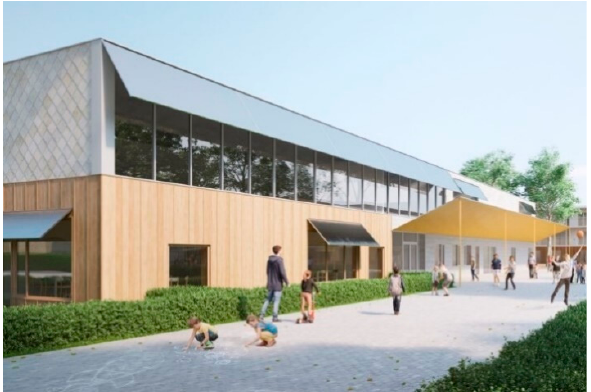
Figure 5. Case study 1: Primary school De Kaart in Brasschaat, province of Antwerp (Belgium). Source: group Van Roey, Compagnie O and Cluster [56].